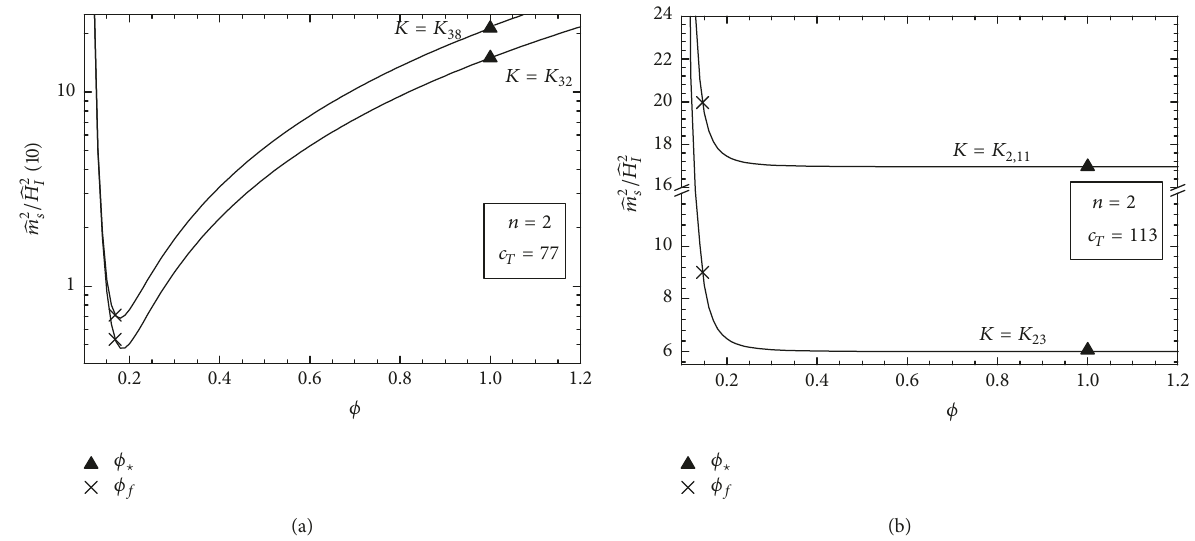
𝜙 for 𝑛 = 2 and 𝜙